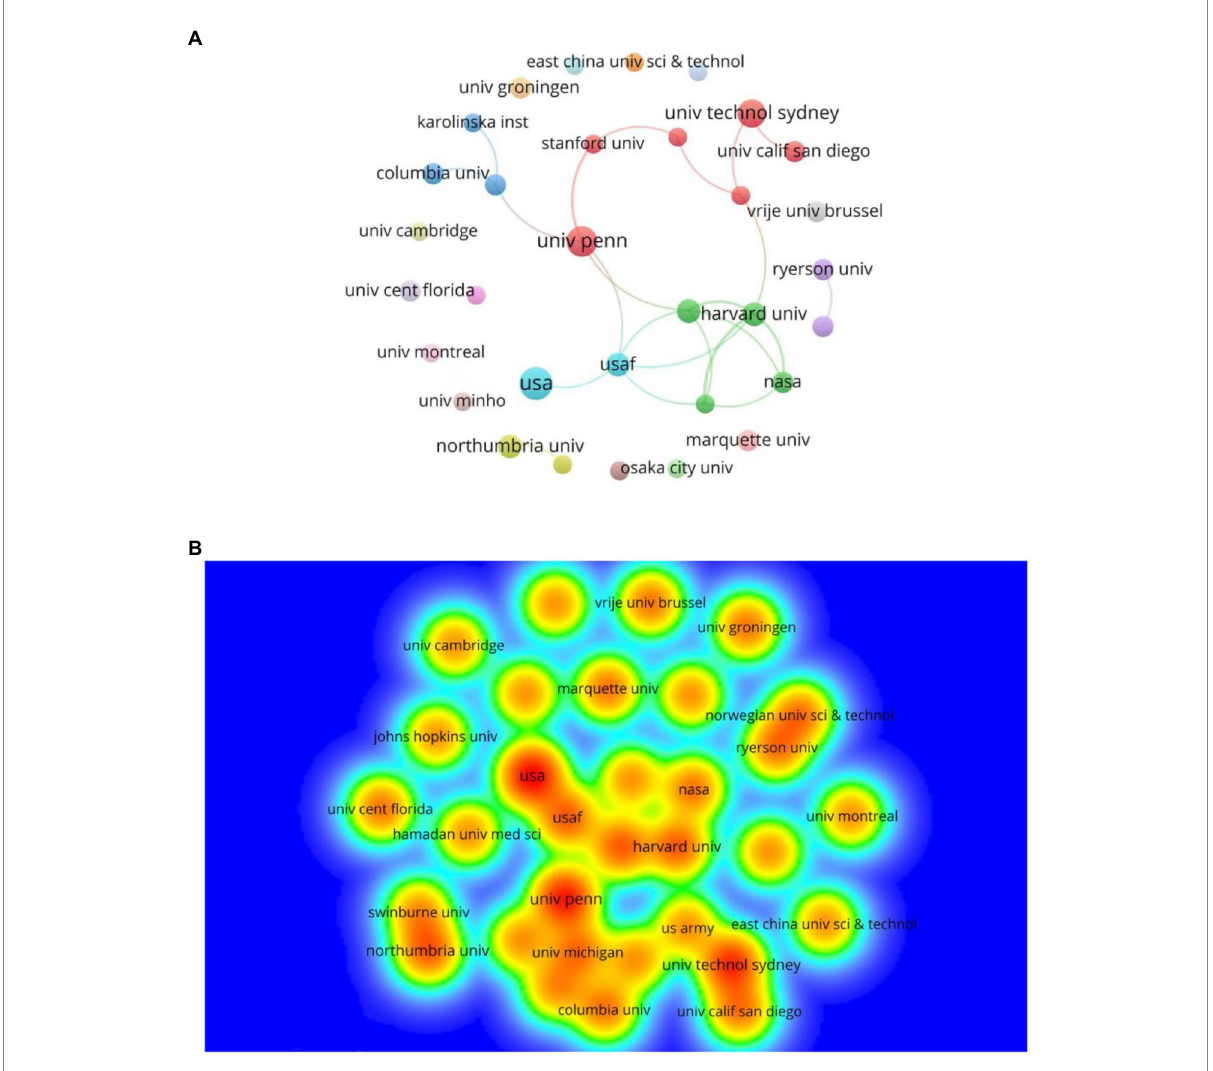
FIGURE 4 (A) The cooperation network visualization map of institutions based on VOSviewer; (B) The density visualization map of institutions based on